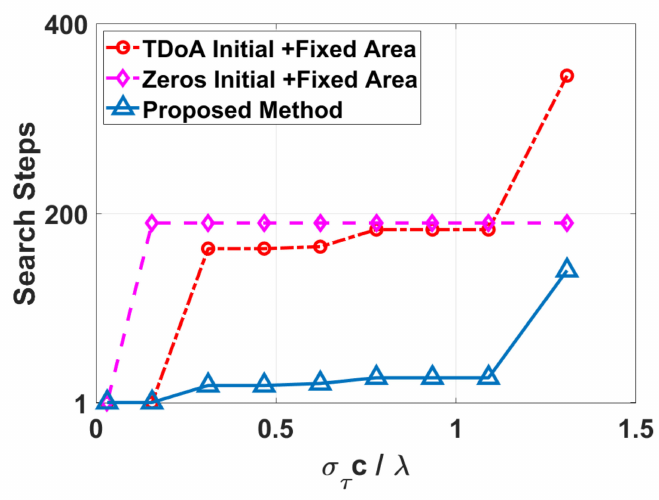
Figure 8. Search Steps of different search strategies.